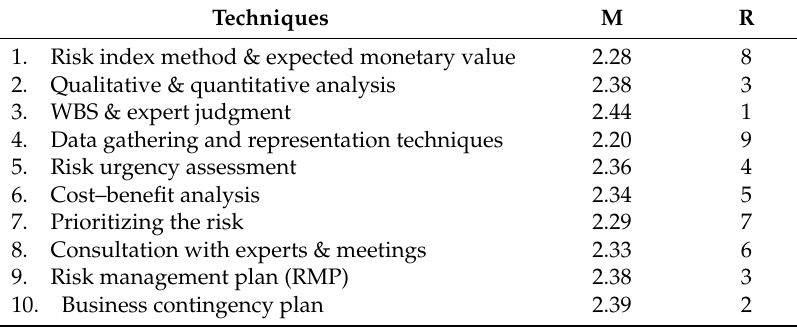
Table 4. Ranking of Risk Assessment and Risk Response